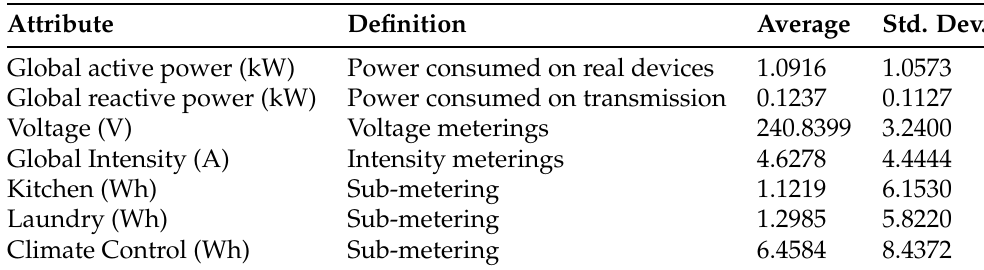
Table 2. UCI household dataset feature